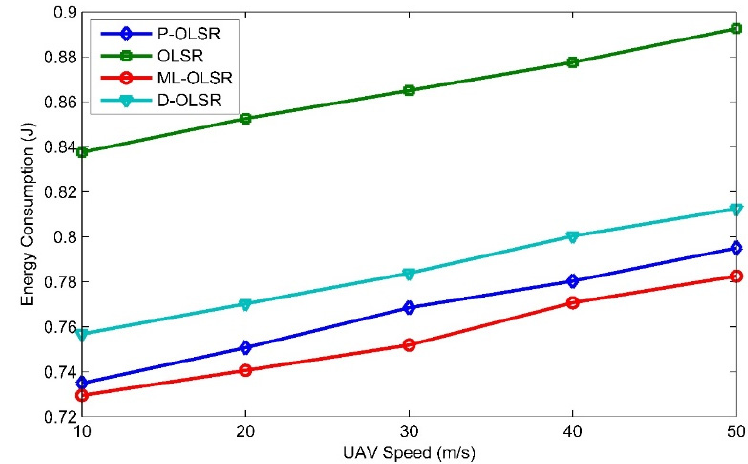
Figure 8. Energy consumption vs. speed of UAVs.